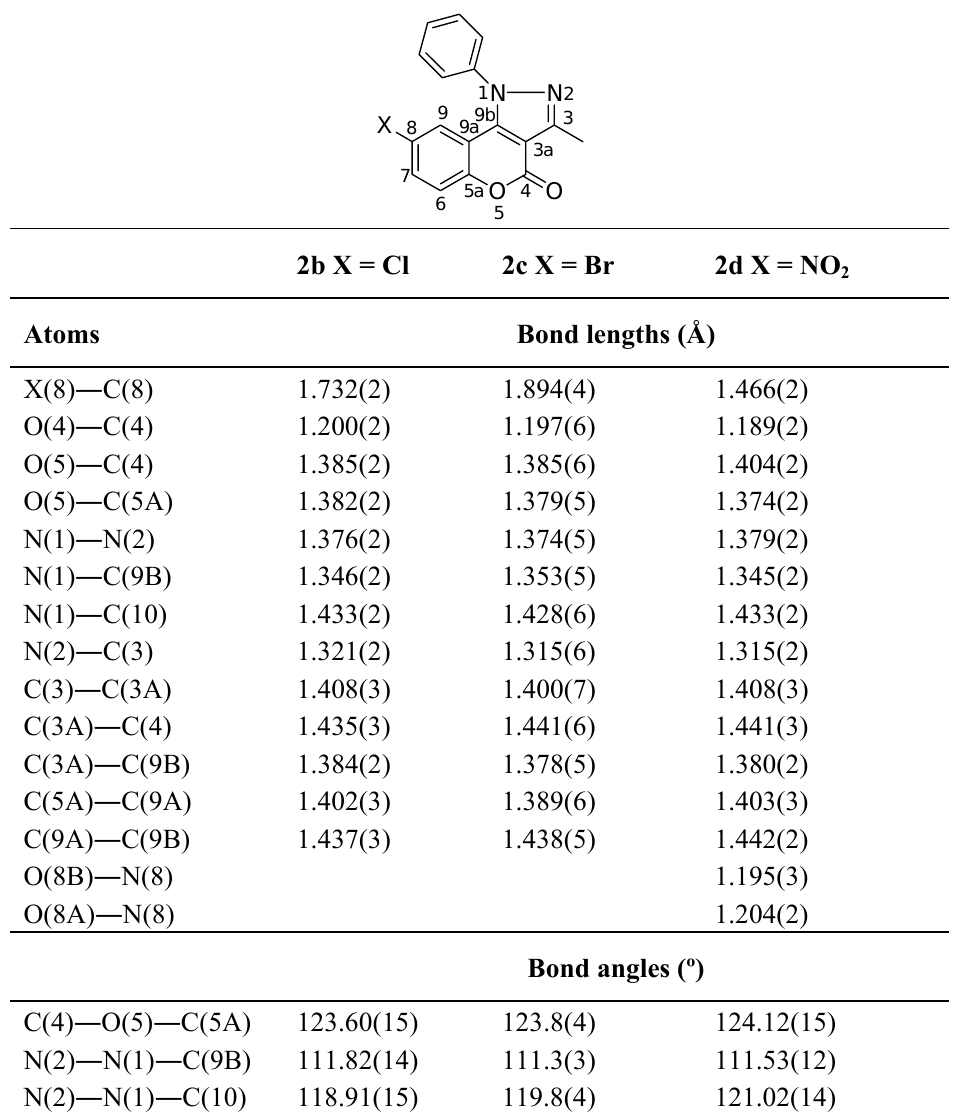
Table 3. Selected bond lengths and angles from X-ray data of compounds 2b-d